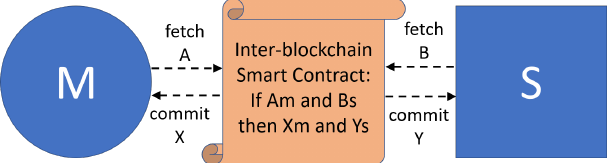
Figure 3. Inter-blockchain smart